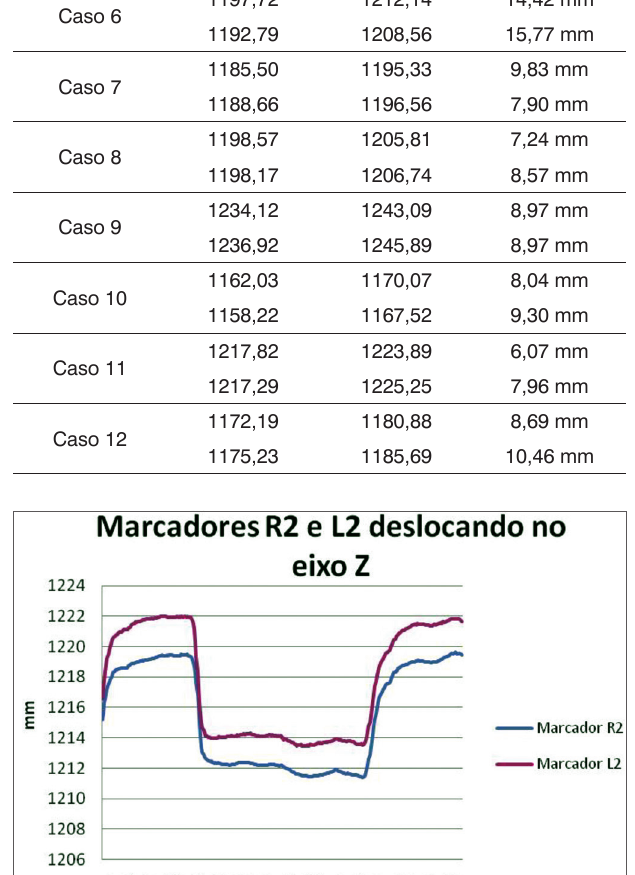
Figura 8. Marcadores R1 e L1 deslocando no eixo Z, enrrugando a